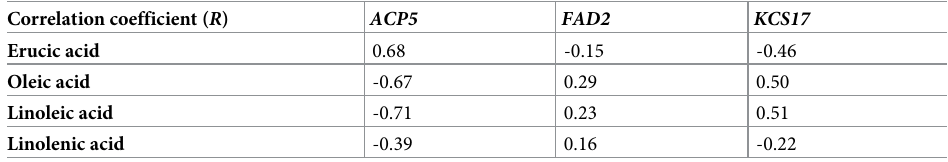
Table 7. The correlation analyses between the expression of three candidate genes and four fatty acid composition of B . napus in